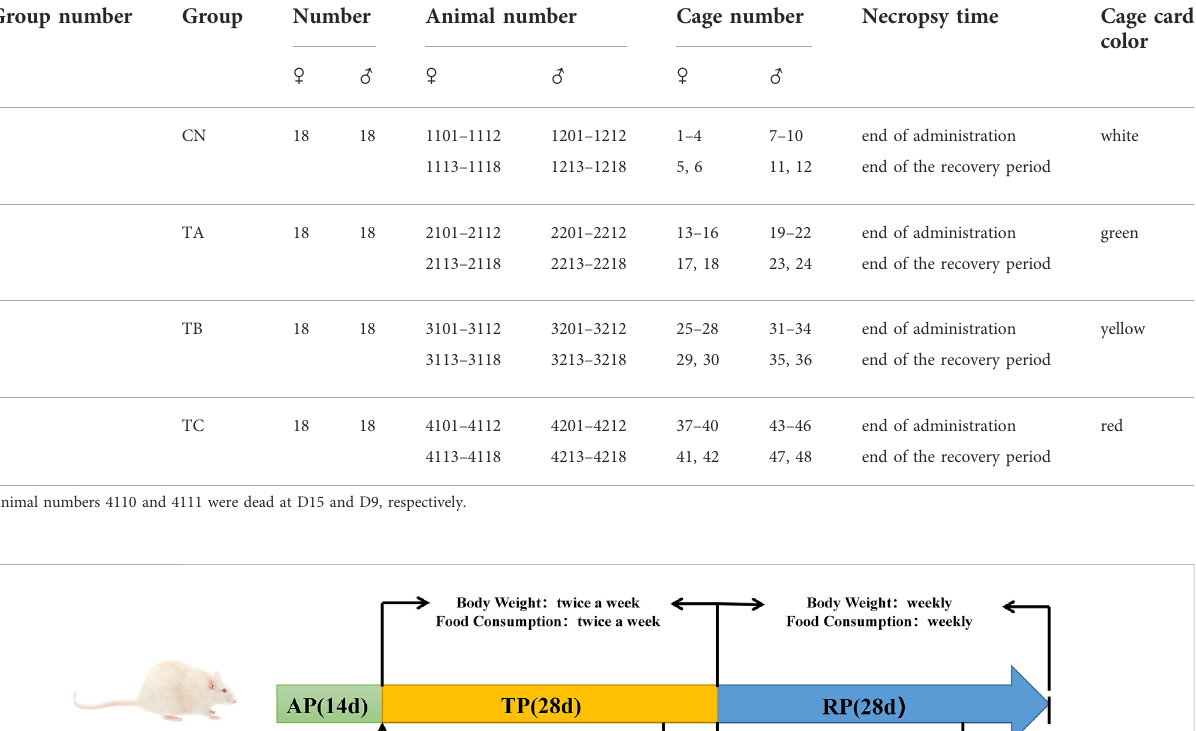
TABLE 1 Group grouping and identi fi cation of test animals.